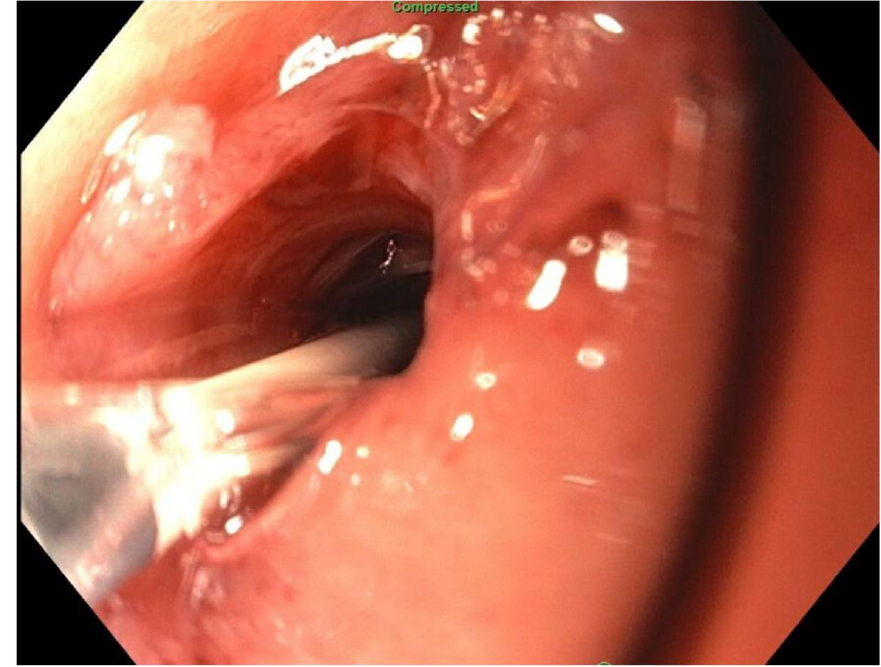
Figure 16. Appearance after dilating.